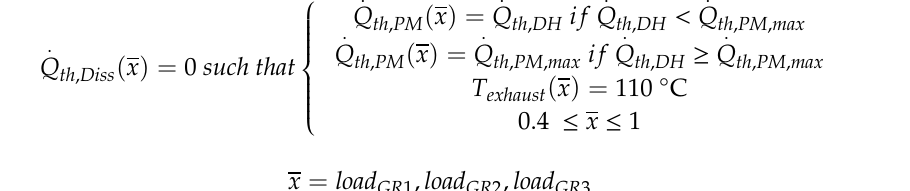
Figure 2. Heat demand yearly profile.